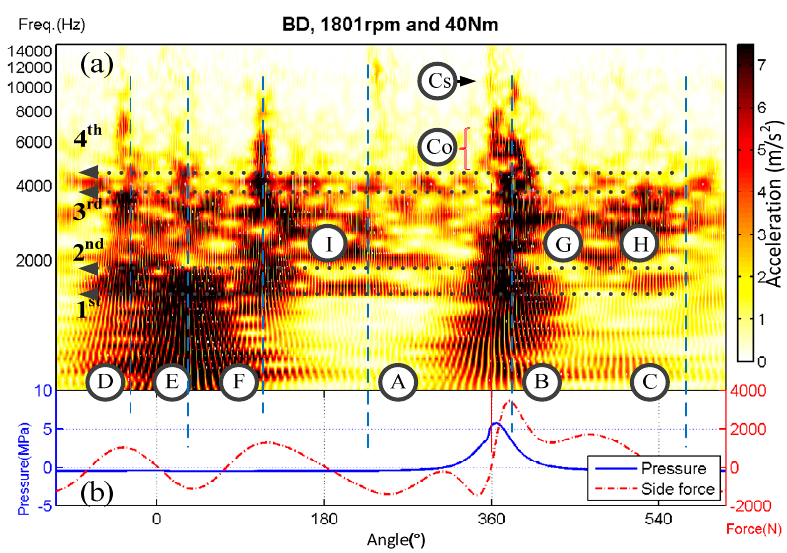
Figure 20. Continuous wavelet transform (CWT) of vibration signal fueled with biodiesel under 40 Nm and 1800 rpm; ( a ) CWT result of measured acceleration response; ( b ) Measured in-cylinder pressure and calculated piston side-thrust force.